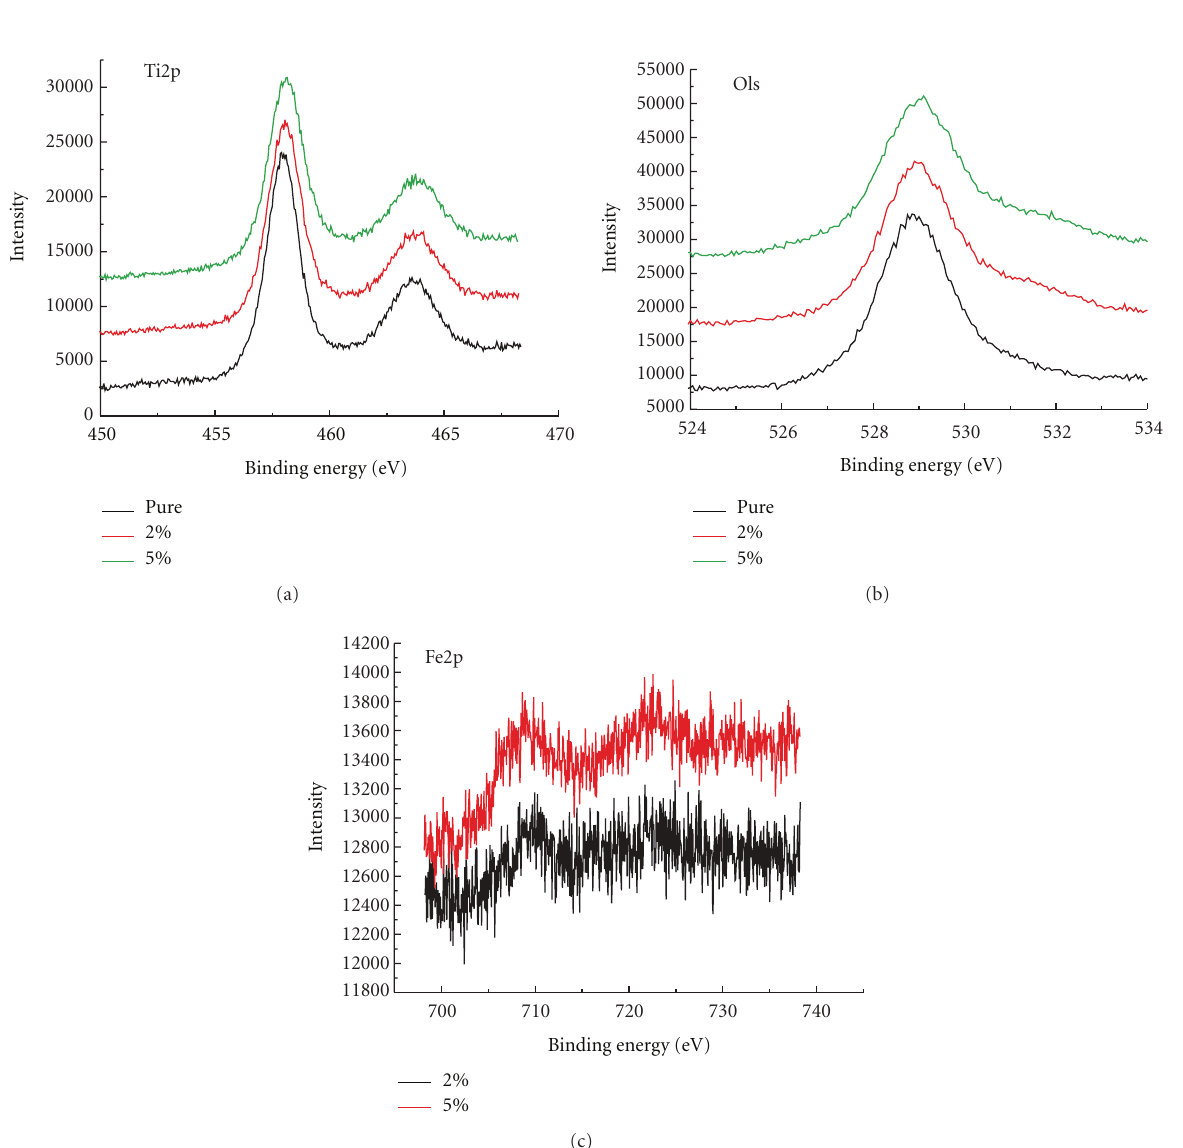
exchange-correction functional in describing excited